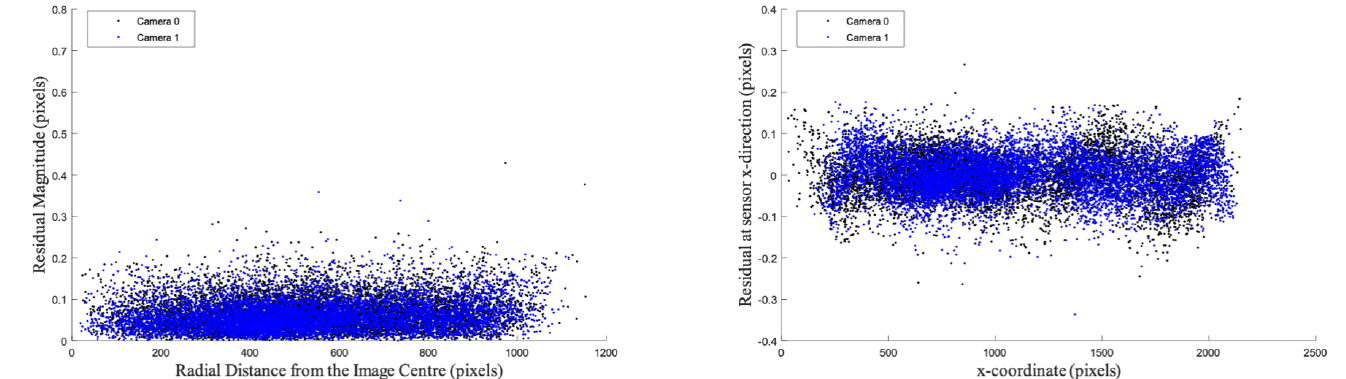
Figure 15. Unmodelled systematic errors in the residuals when using our calibration model and after adding the quartic distortion terms described in Equation (9). ( Left ) The magnitude of the residuals. ( Right ) The x-component of the residuals.